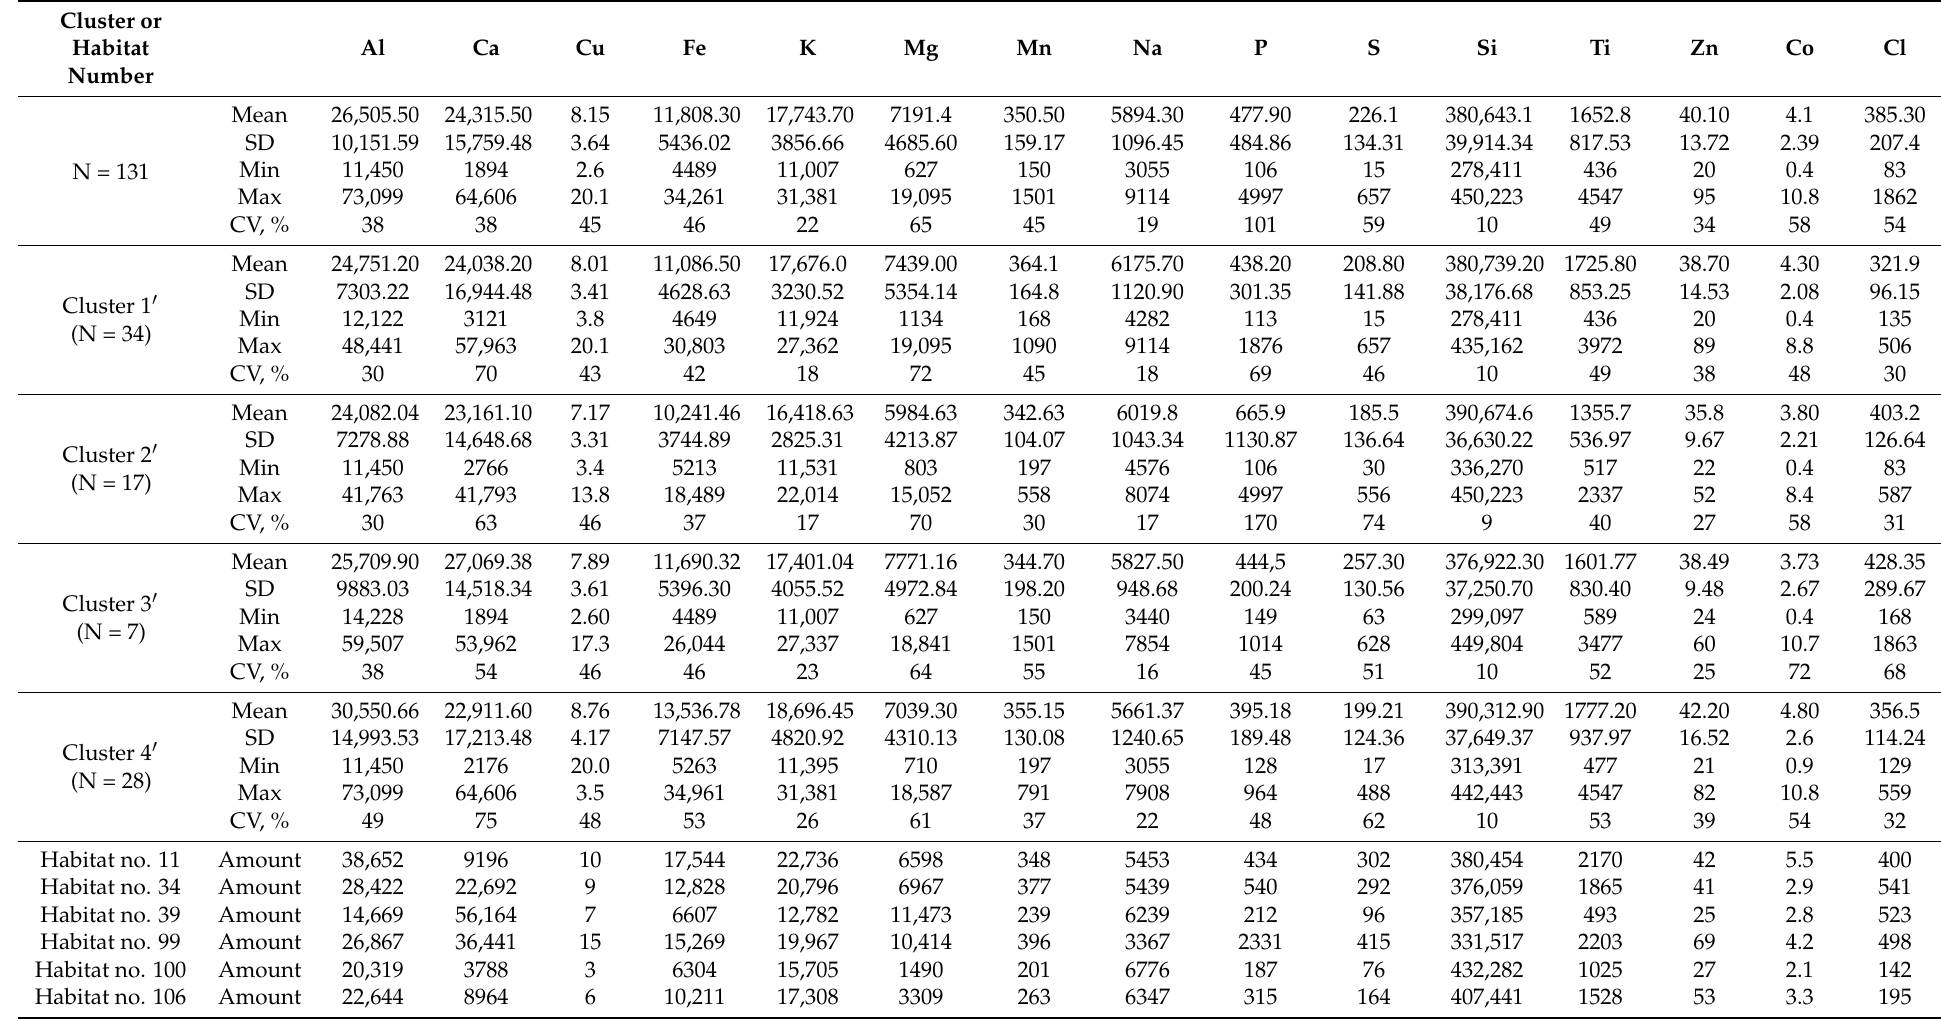
Table 4. Descriptive statistics of chemical elements of soil in distinguished clusters of Thymus pulegioides habitats and habitats no. 11, no. 34, no. 39, no. 99, no. 100 and no.